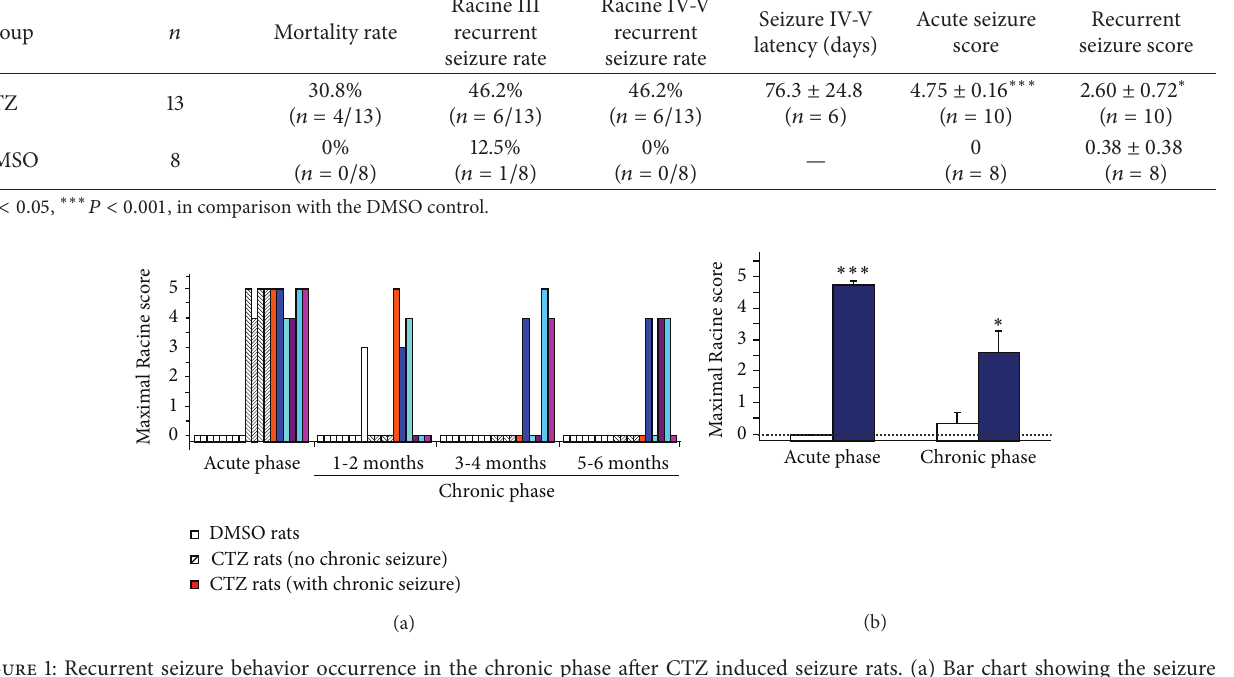
Table 1: Recurrent seizure behavior (Racine score IV-V behavior) occurrence in the chronic phase in CTZ induced seizure rats. Group 𝑛